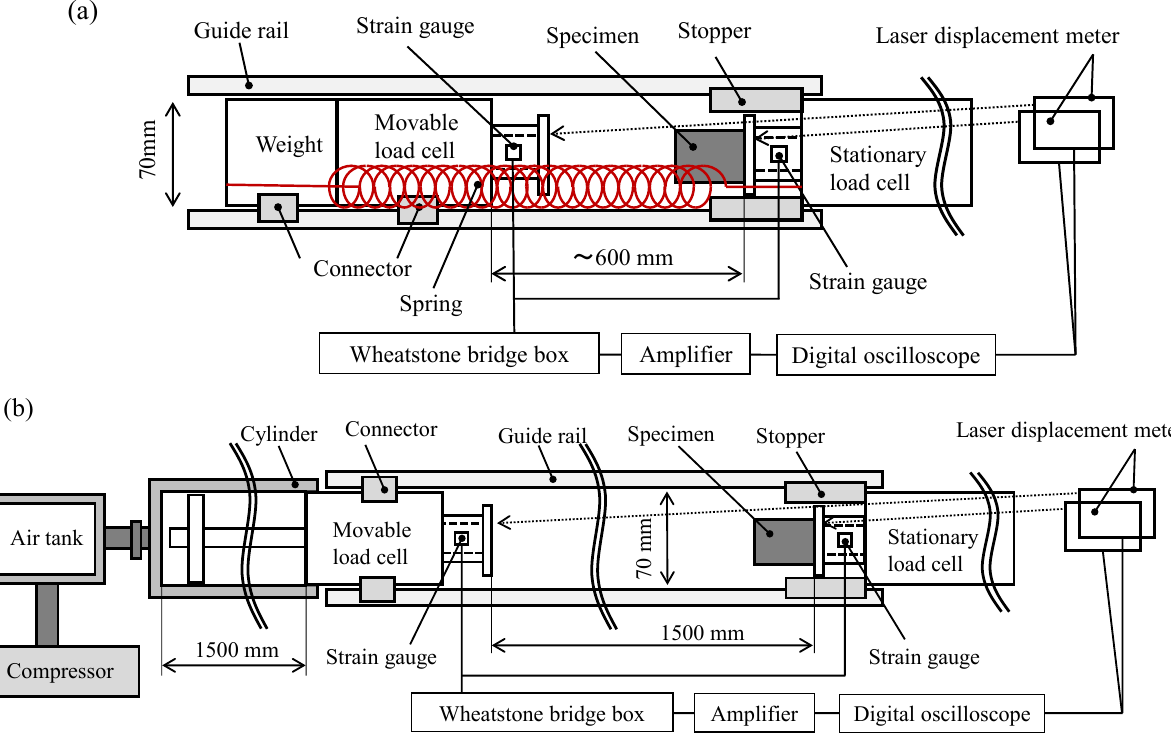
Figure 4. Schematics of dynamic ( a ) and impact ( b ) load-measuring apparatus with opposite load cells.